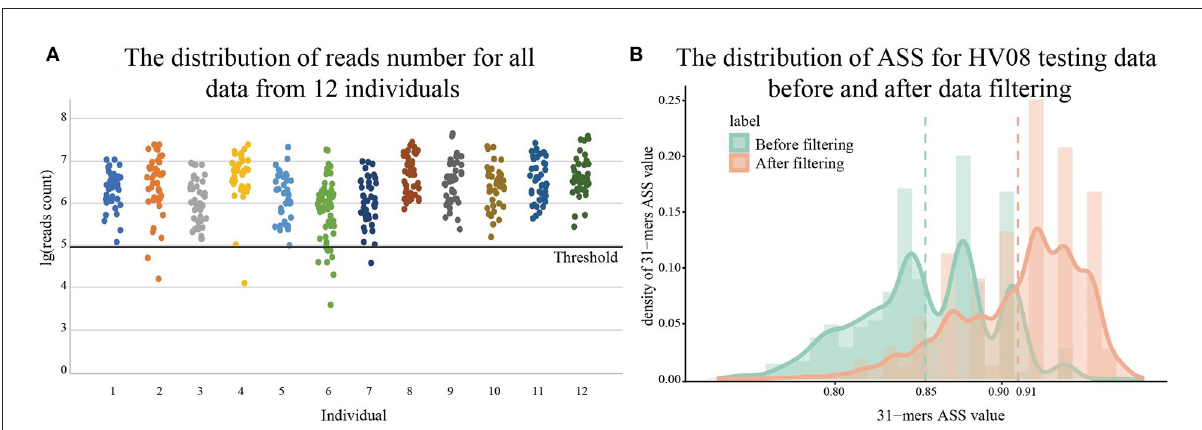
FIGURE2 Preprocessing of metagenomic sequencing data. The scatterplot in (A) shows the distribution of read counts of samples from 12 healthy volunteers (HV). The data with the log of reads number fewer than 100,000 are removed. The bar chart in (B) shows the improvement of ASS values by data processing on the test dataset identifying HV08. The overall distribution of ASS values for 31-mers obtained after data processing can be seen as having shifted to the right in the figure, which means data processing improved the quality of k -mers we want to find. Dotted lines in the figure denote the mean